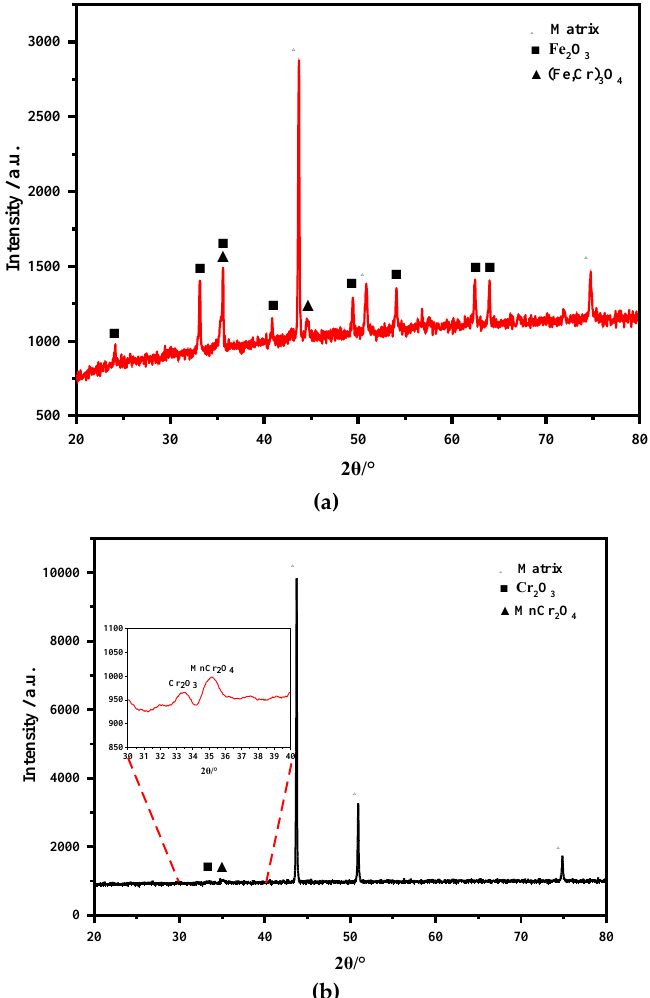
Figure 12. XRD results of TP347H and TP347HFG after 168 h at 700 °C. ( a ) TP347H; ( b ) TP347HFG.